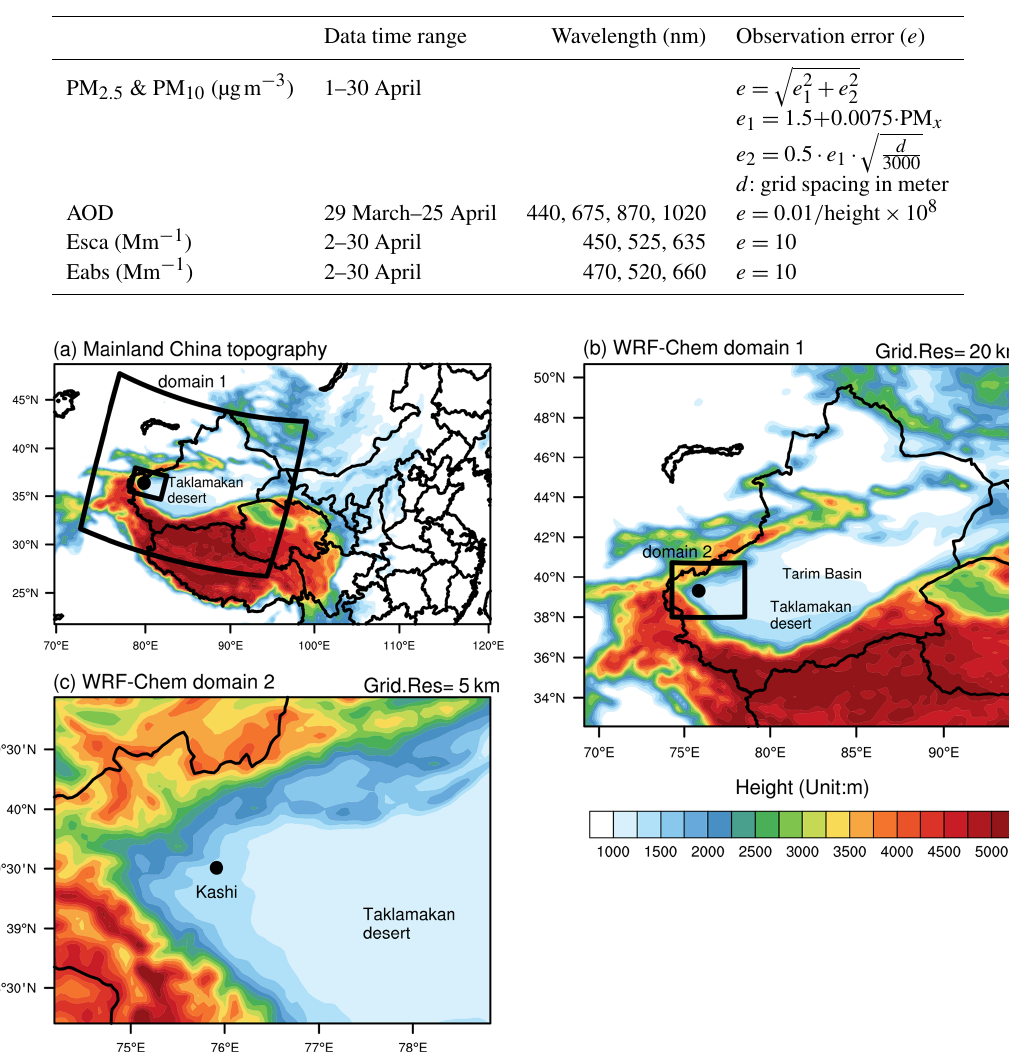
two pairing calls was aerosol radiative forcing. Section